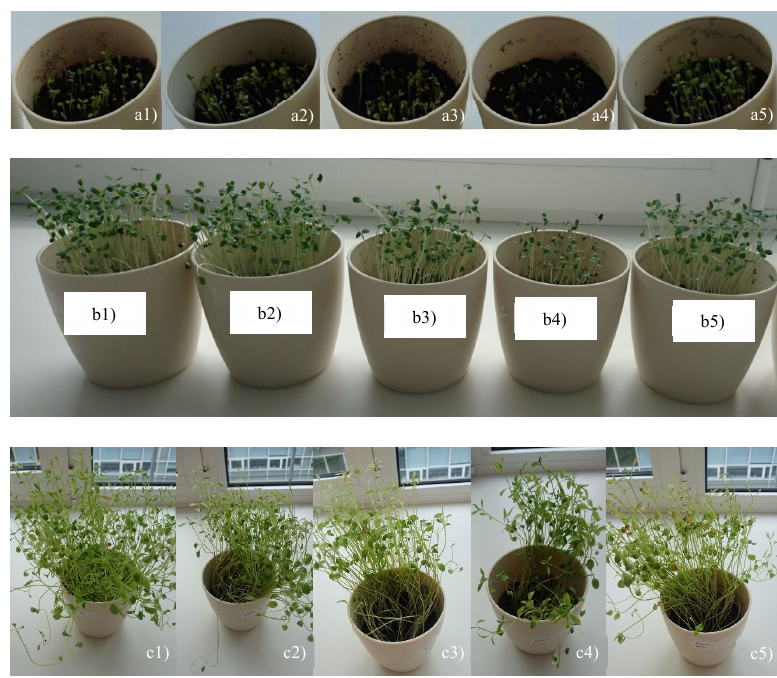
Figure 1. ( a ) The garden candytuft appearance ( a ) after five days of cultivation; ( b ) after ten days of cultivation; ( c ) after forty days of cultivation: ( a1 / b1 / c1 ) control sample; ( a2 / b2 / c2 ) in humus with the addition of egg shells; ( a3 / b3 / c3 ) in humus with the addition of extra humus; ( a4 / b4 / c4 ) in untreated humus watered with CuSO 4 · 5H 2 O; ( a5 / b5 / c5 ) in humus with the addition of zeolite